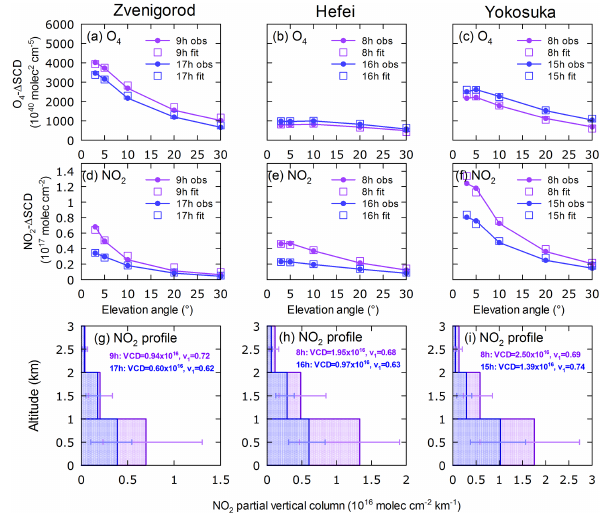
Figure 5. (a) – (f) Observed and fitted O 4 1 SCDs and NO 2 1 SCDs, and (g) – (i) optimally estimated NO 2 vertical profiles averaged over each 1h period in the morning and afternoon at the Zvenigorod, Hefei, and Yokosuka sites, respectively. For (g) – (i) , error bars rep- resent 1 σ range of individual profiles included in the